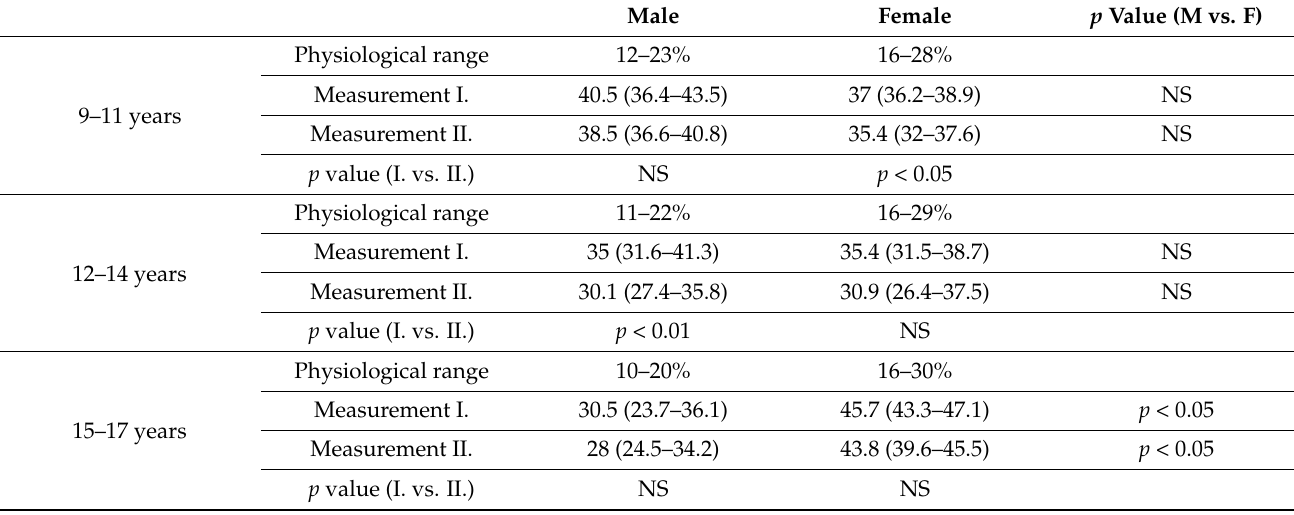
Table 3. Percentage of fat